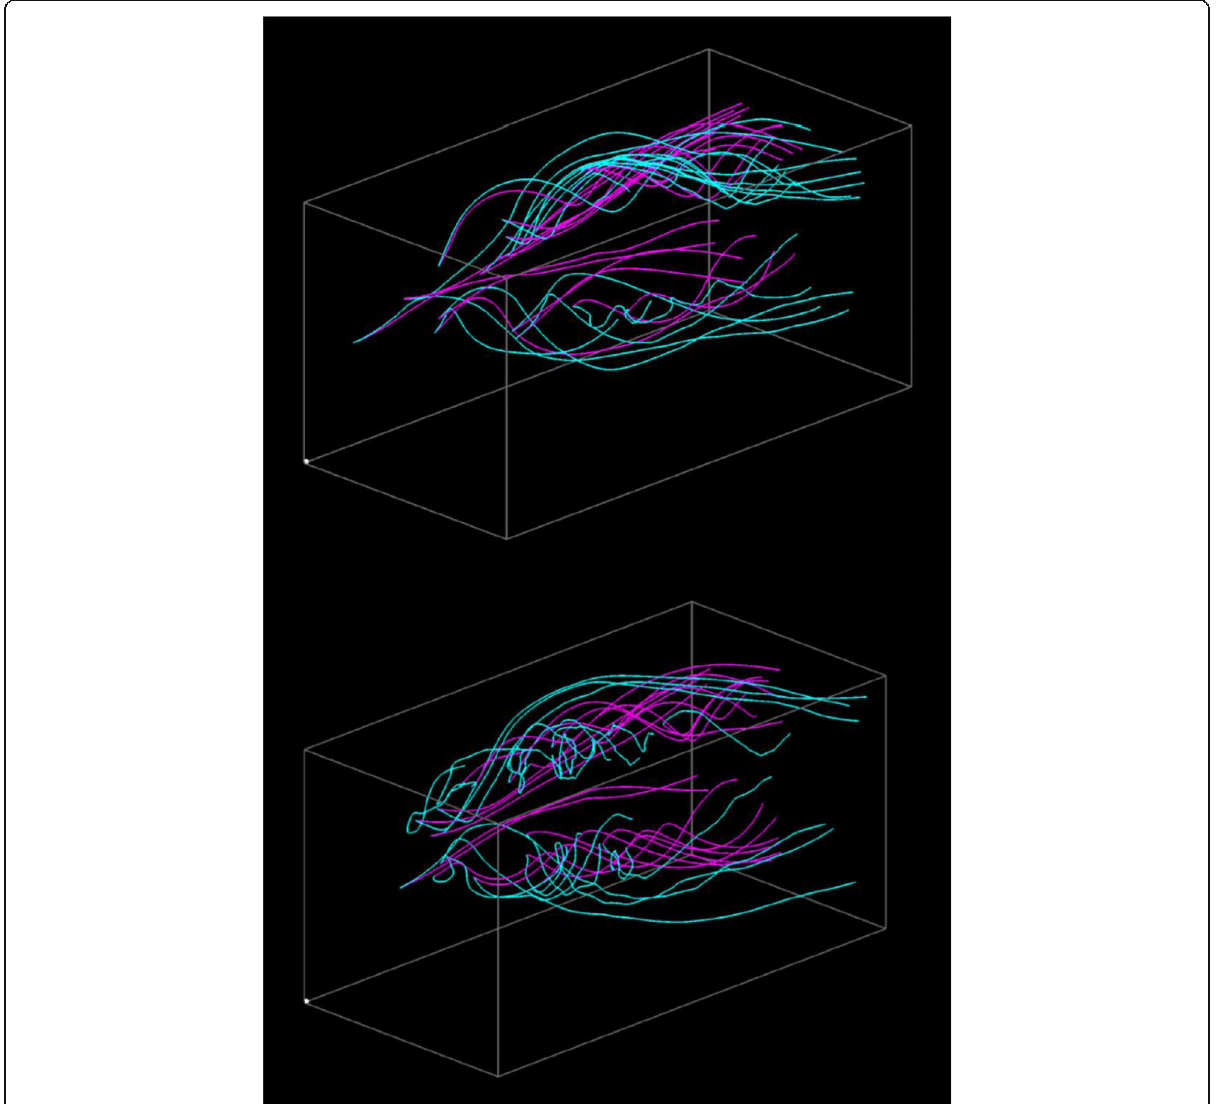
Fig. 7 Visualization results. (Upper) The angles of attack are 20 and 27 degrees. (Lower) The angle of attack are 20 and 33 degrees